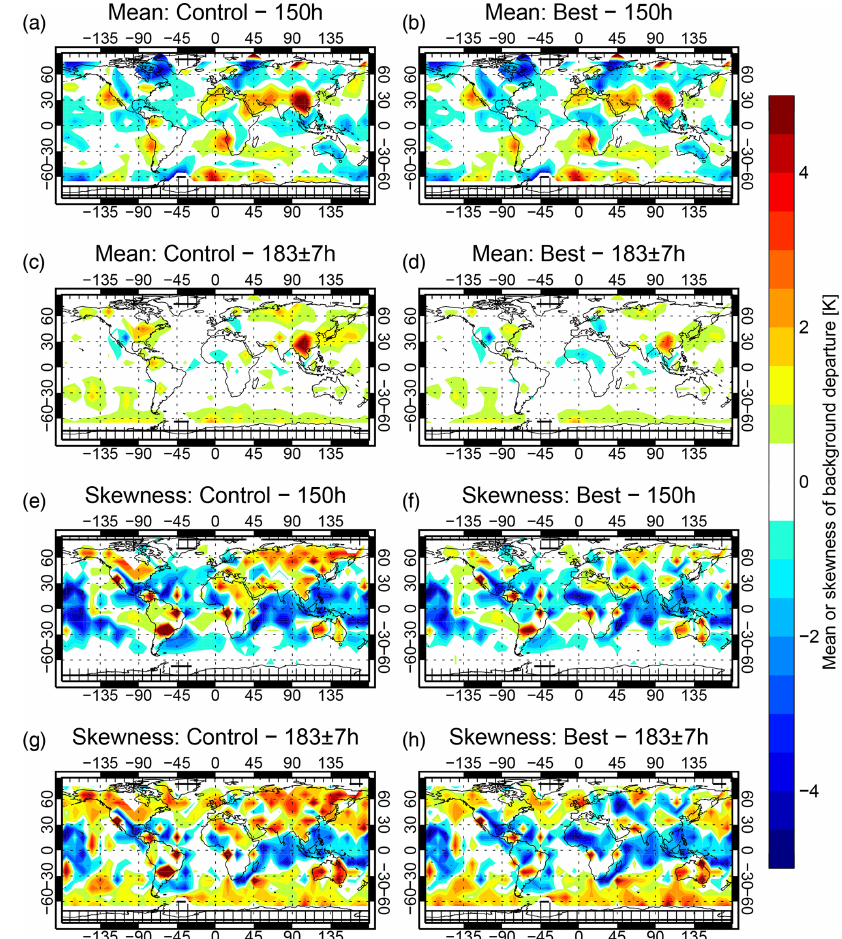
Figure 7. Maps of mean and skewness of background departure in the control and in the best configuration.